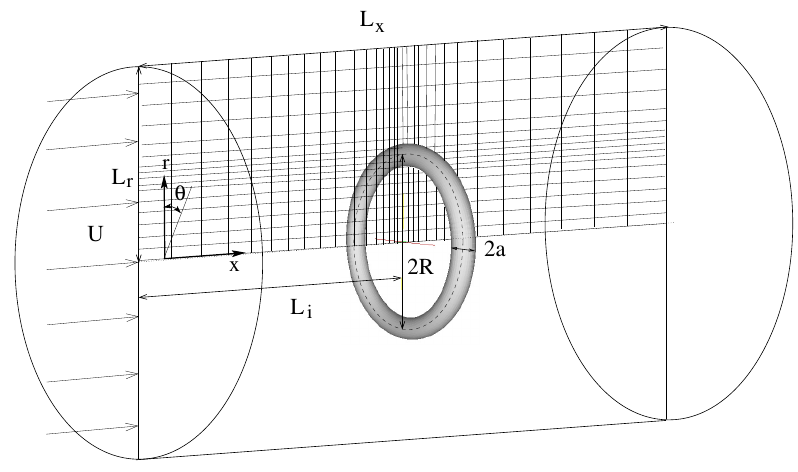
Figure 2. Sketch of the